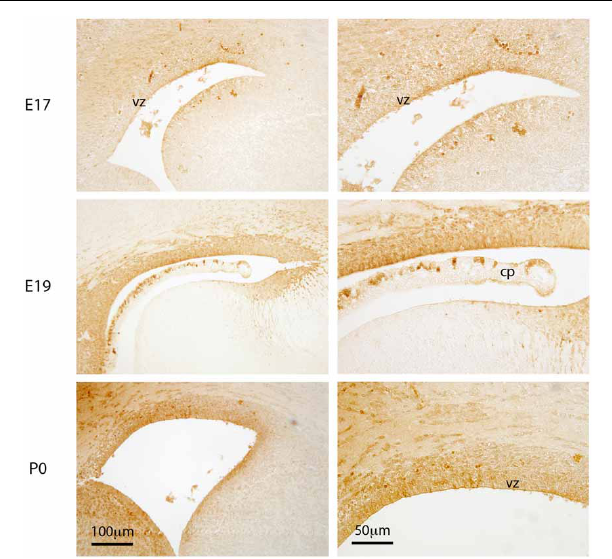
FIGURE 2 | Distribution of Biotin Ethylene Diamine (BED). Coronal sections (paraffin embedded) through cortical wall surrounding lateral ventricles of E17, E19, and P0 mouse brain after BED injection into the contralateral ventricle. Developed with DAB reaction. Note that at E17 there is cellular uptake of BED in some regions of the ventricular zone, but none appears to have penetrated into the brain extracellular space. At E19 and P0 there is both cellular uptake and diffusion into the extracellular space of the brain, especially into the ventral side of the ventricle. Much less staining is detected in the medial wall at all three ages. VZ, ventricular zone; CP, choroid plexus. Scale bar 100 μ m in left panels and 50 μ m in right